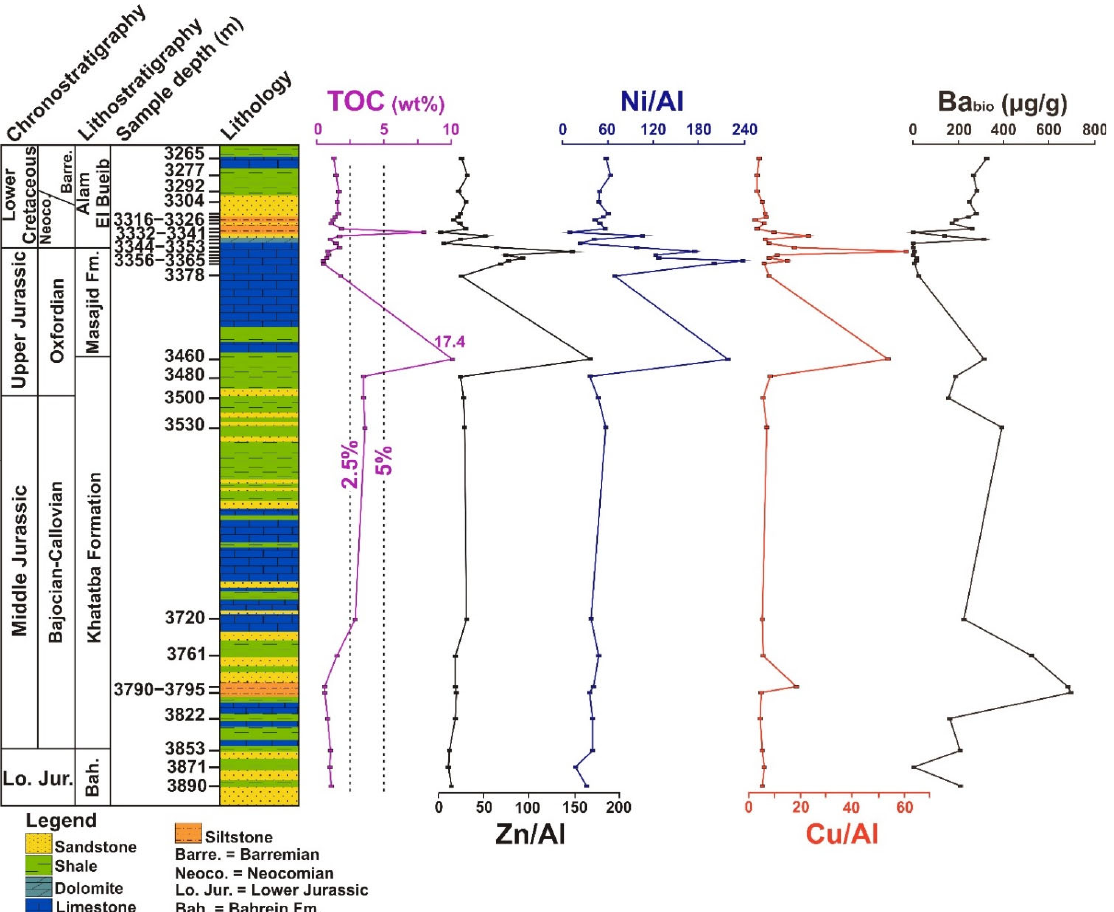
Figure 5. Chemostratigraphic distribution of TOC and paleoproductivity elemental proxies of the Jurassic–Lower Cretaceous sediments from the Almaz ‐ 1 well, Shushan Basin.